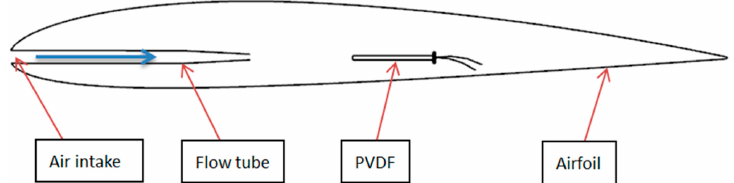
Figure 33. Scheme of jet-edge EH device in an aerofoil [194]-licensed under a Creative Commons Attribution (CC BY).